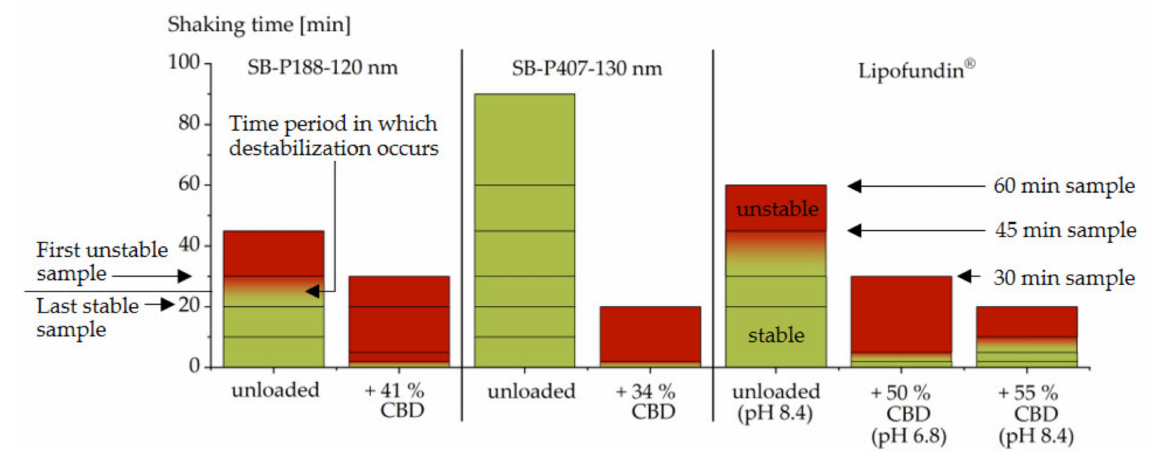
Figure 6. Stability of soybean oil emulsions stabilized with poloxamer 188 (P188) or poloxamer 407 (P407), respectively, and Lipofundin ® (composed of phospholipids, medium chain triglycerides and soybean oil) before and after loading with cannabidiol (CBD). Shaking periods that did not induce instability are shown in green, intervals of unstable samples in red; the first destabilizing interval is marked with a color gradient. Investigated samples points are included as